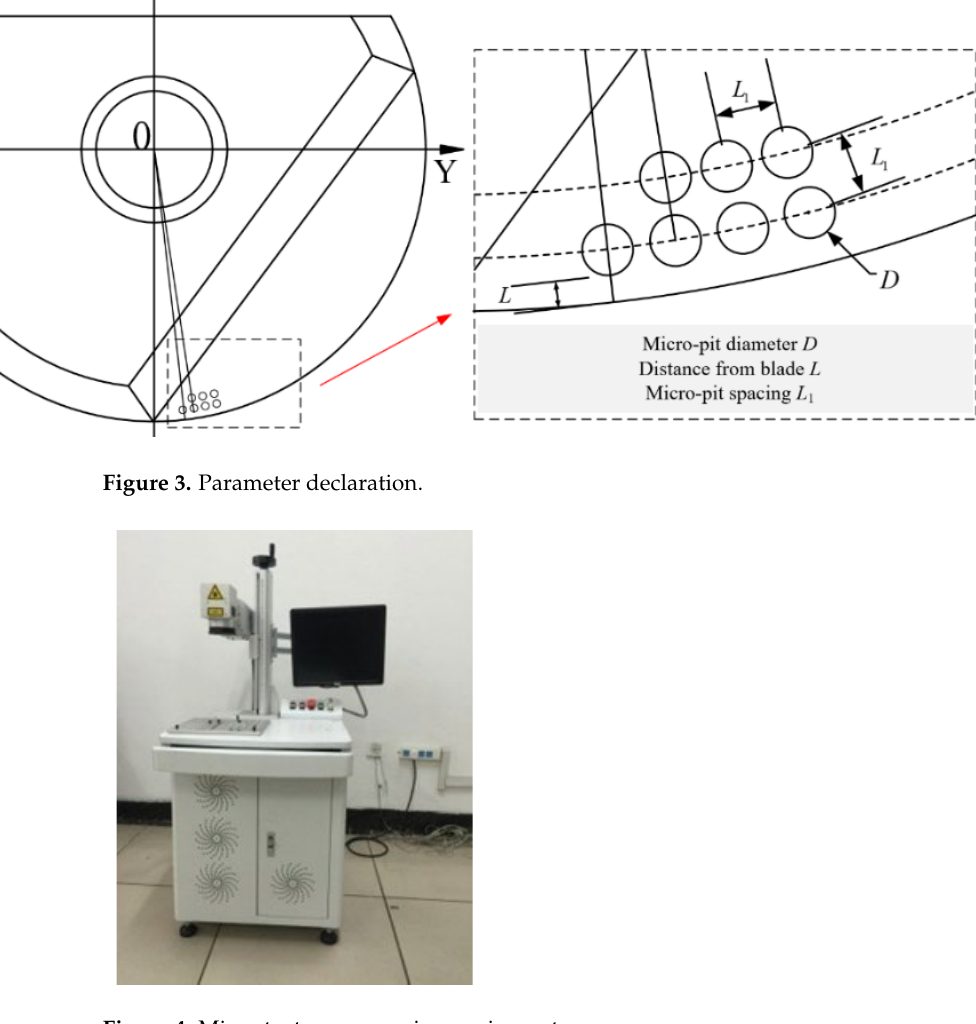
Figure 4. Micro-texture processing equipment.